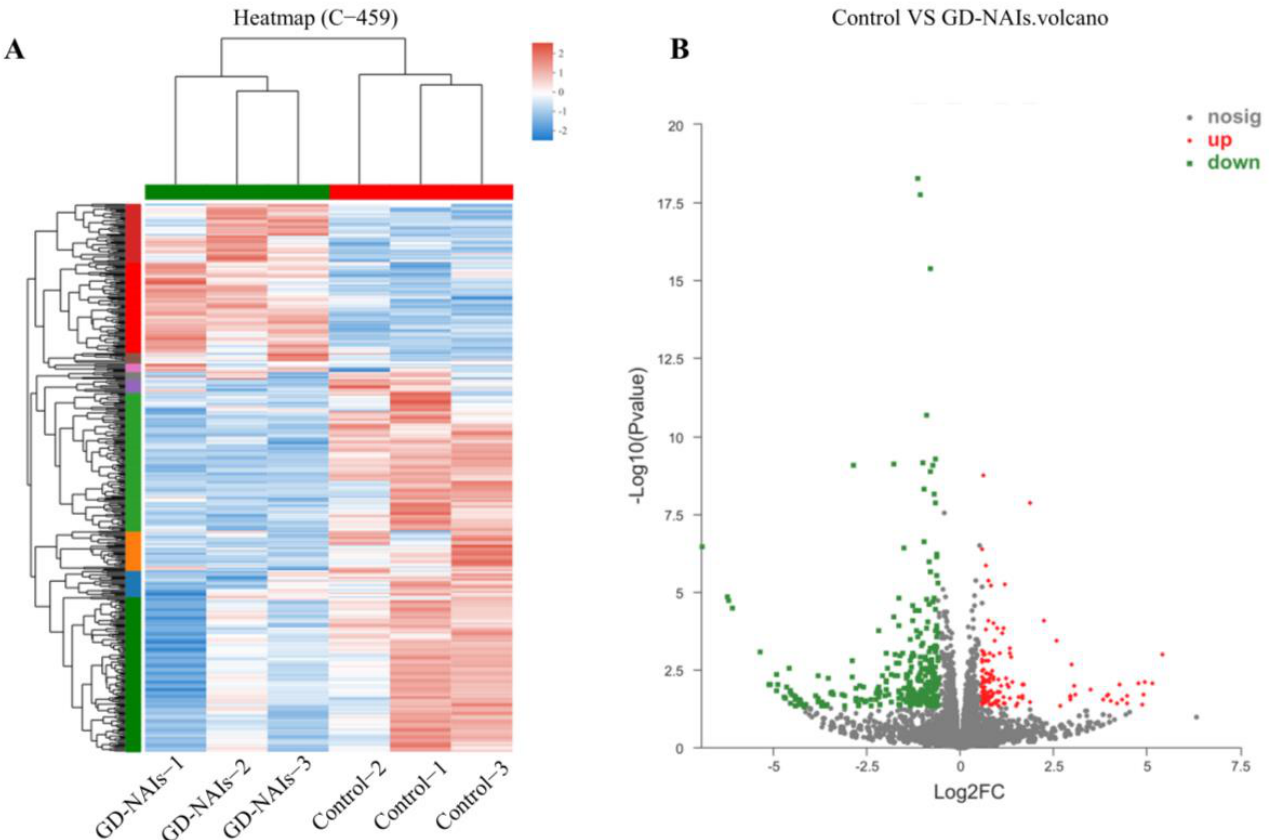
Figure 7. Gene expression profile induced by GD-NAIs. ( A ) Hierarchical clustering analysis of DEGs between the control and GD-NAIs-treated groups. ( B ) Volcano plot of DEGs between the control and GD-NAIs-treated groups.